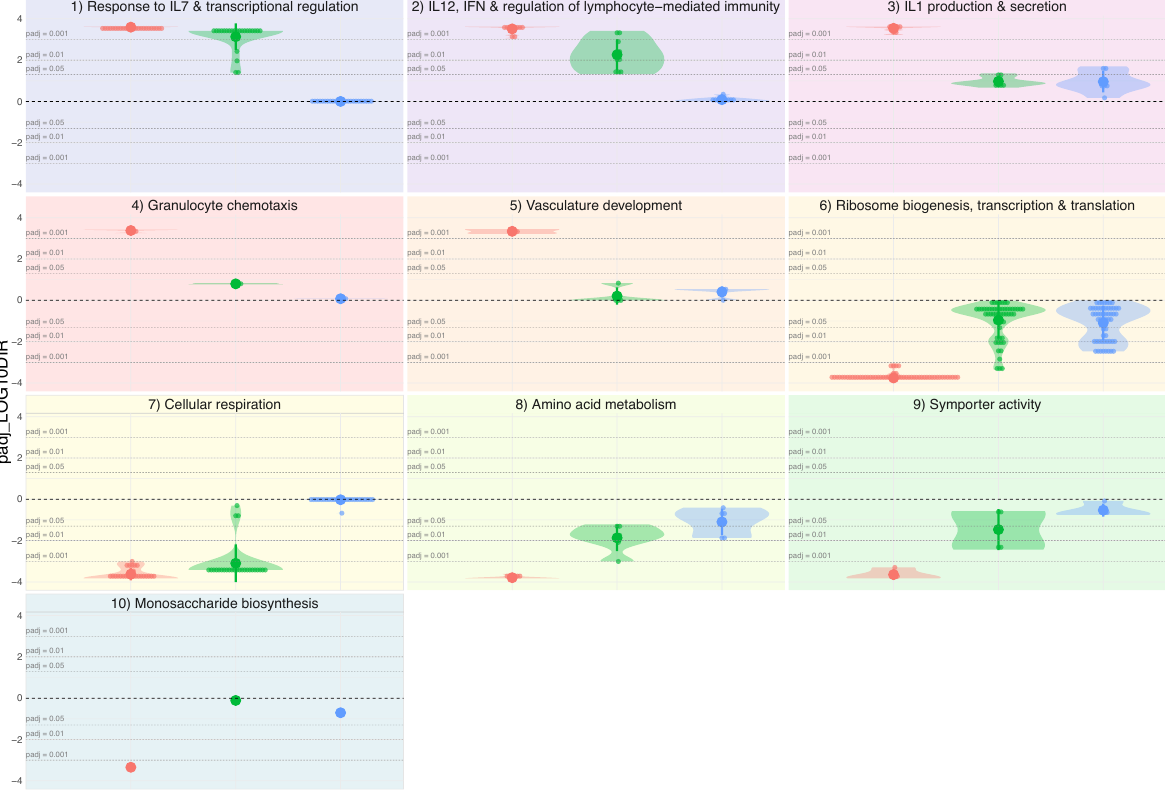
Figure 4. Violin plots displaying directional adjusted p -values for all comparisons per biological theme identified as significantly altered in MCD vs. N_CTRL. Adjusted p -values were log-transformed (log10), and the algebraic sign was assigned according to positive and negative enrichment signal, respectively. The dashed black horizontal line corresponds to an adjusted p -value 1, whereas the dashed grey horizontal lines indicate significance levels of adjusted p -values of 0.05, 0.01 and 0.001 for enrichment and depletion, respectively, as